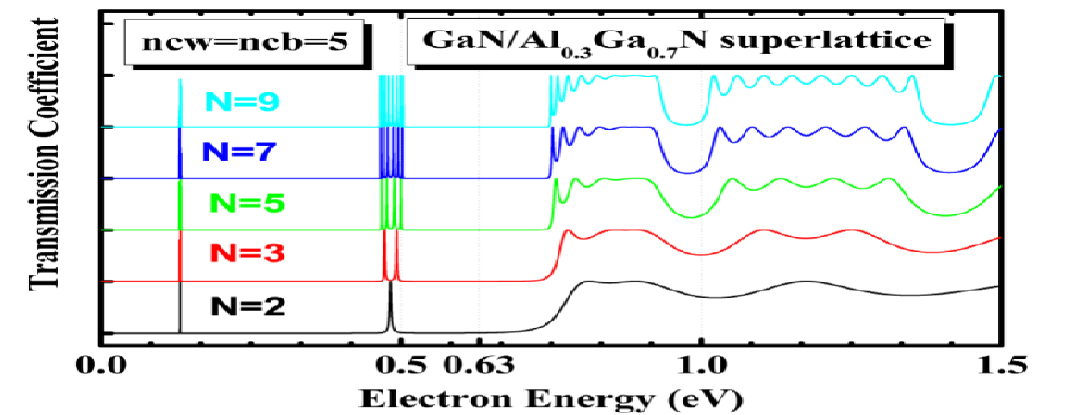
Fig. 2: Transmission coefficient T(E) versus incident energy (E) for GaN/Al system by varying N, and constant ncw = ncb = 5